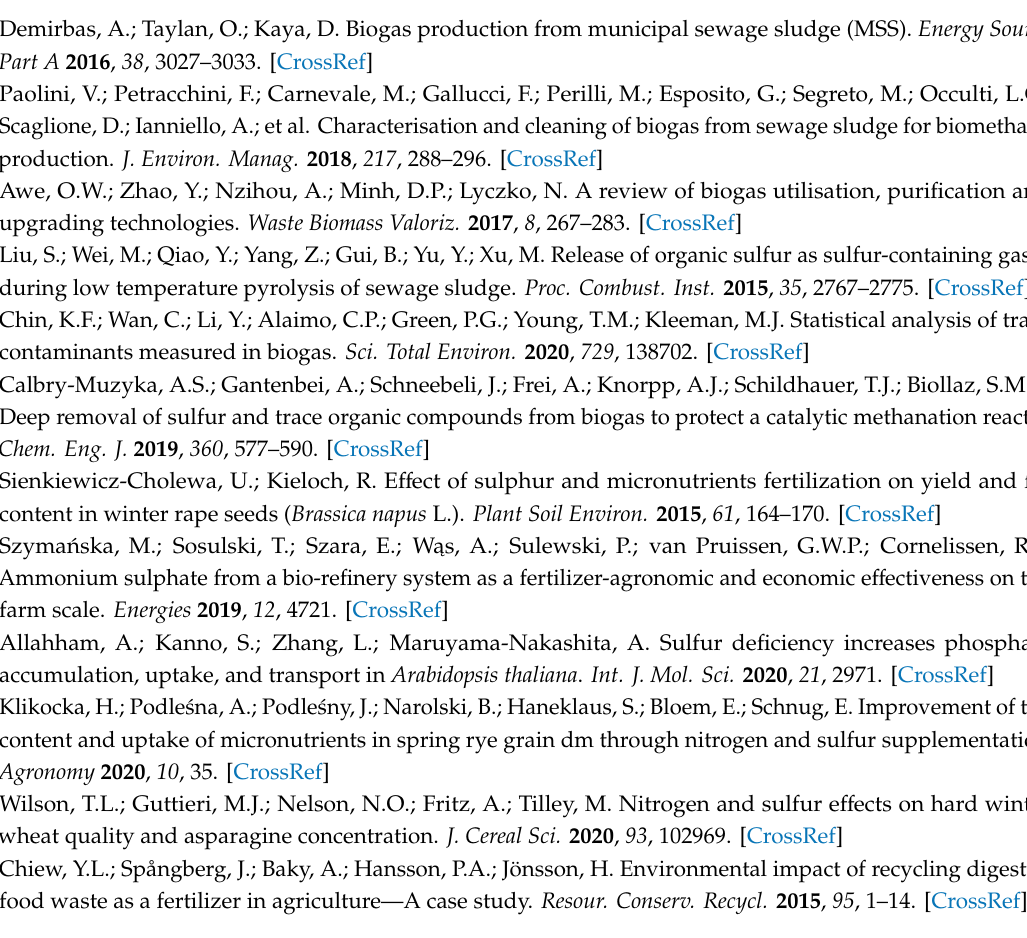
Table S1: Wavelengths and quantification limits for the ICP-OES